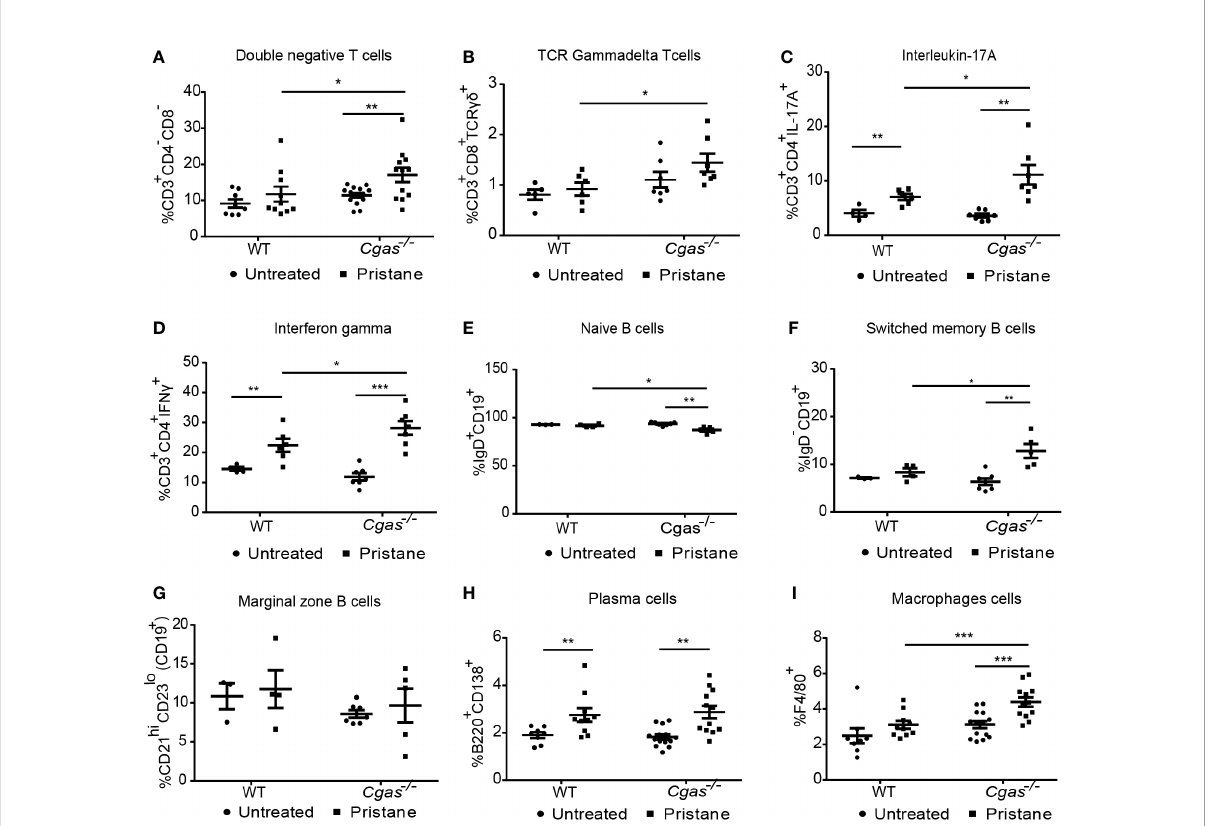
FIGURE 3 The absence of cGAS accelerates the increase of in fl ammatory T cells and macrophages in pristane-induced lupus. (A – I) Flow cytometry analysis of splenocytes isolated from WT and Cgas -/- mice at 8 months after pristane injection (n = 8-14 per group). Data are shown as the percentage of (A) double-negative T cells (CD3 + CD4 - CD8 - ), (B) TCR gamma-delta T cells (CD3 + CD8 + TCR- gd + ), (C) interleukin-17A (CD3 + CD4 + IL-17A+), (D) interferon-gamma (CD3 + CD4 + IFN- g + ), (E) naïve B cells (CD19 + IgD + ), (F) switched memory B cells (CD19 + IgD - ), (G) marginal zone B cells (CD19 + CD21 hi CD23 low ), (H) plasma cells (B220 + CD138 + ), and (I) macrophage cells (F4/80 + ). Data are shown as the mean ± SEM. *p < 0.05, **p < 0.01, *** p <